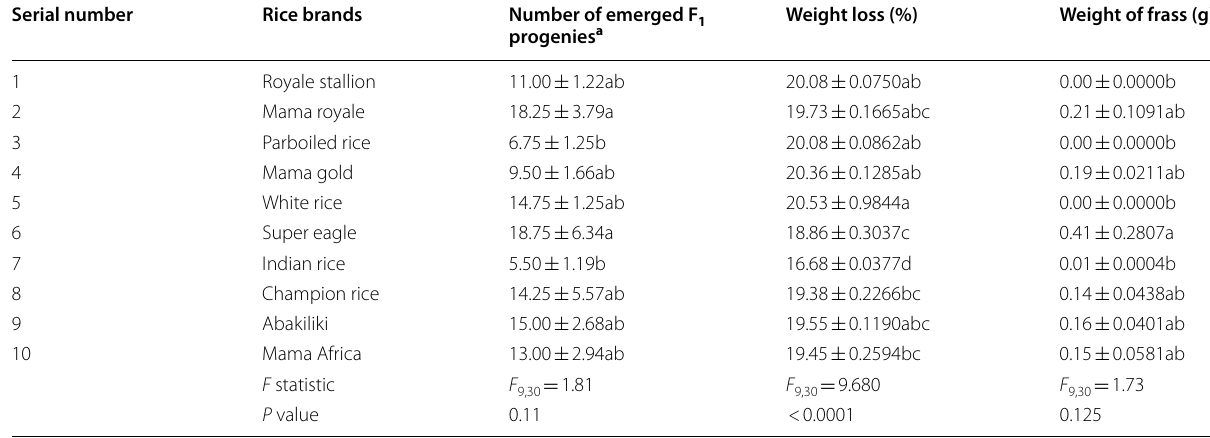
Data are means SEM of four replications ± Mean values in a column with same letter are not significantly different by HSD ( α